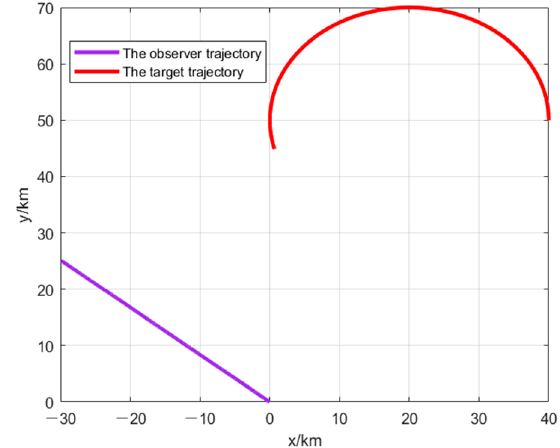
Figure 1. The trajectory of target and observer.